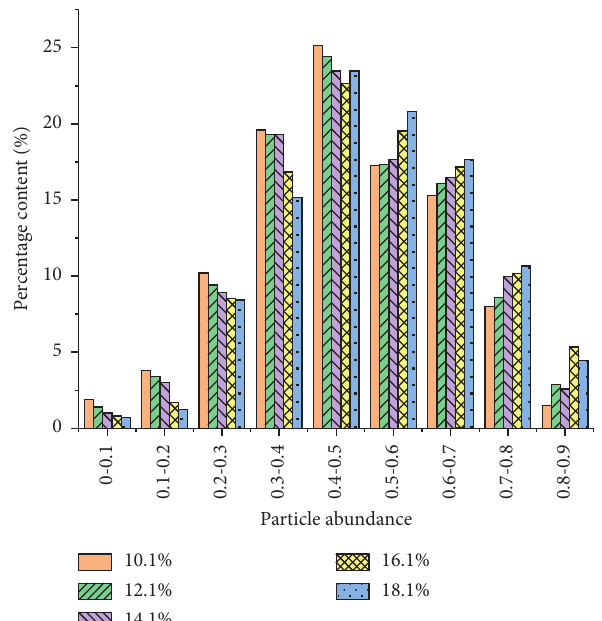
Figure 10: Abundance percentage content of undisturbed soil particles.